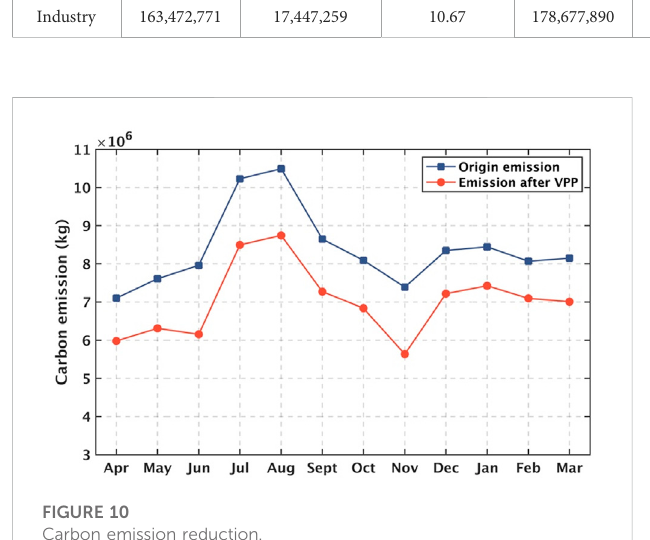
FIGURE 10 Carbon emission reduction.